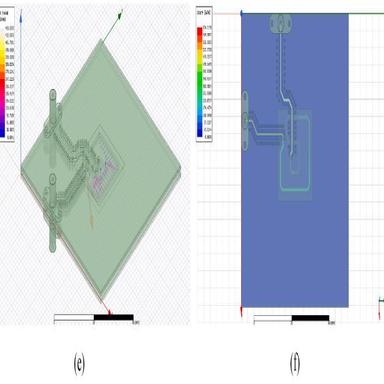
Simulation results for paired fixtures: (a) S-parameters in the 0.2 GHz~6 GHz frequency band; (b) radiation pattern; (c) 3D pattern; (d) E field; (e) H field; (f) current density (top view).